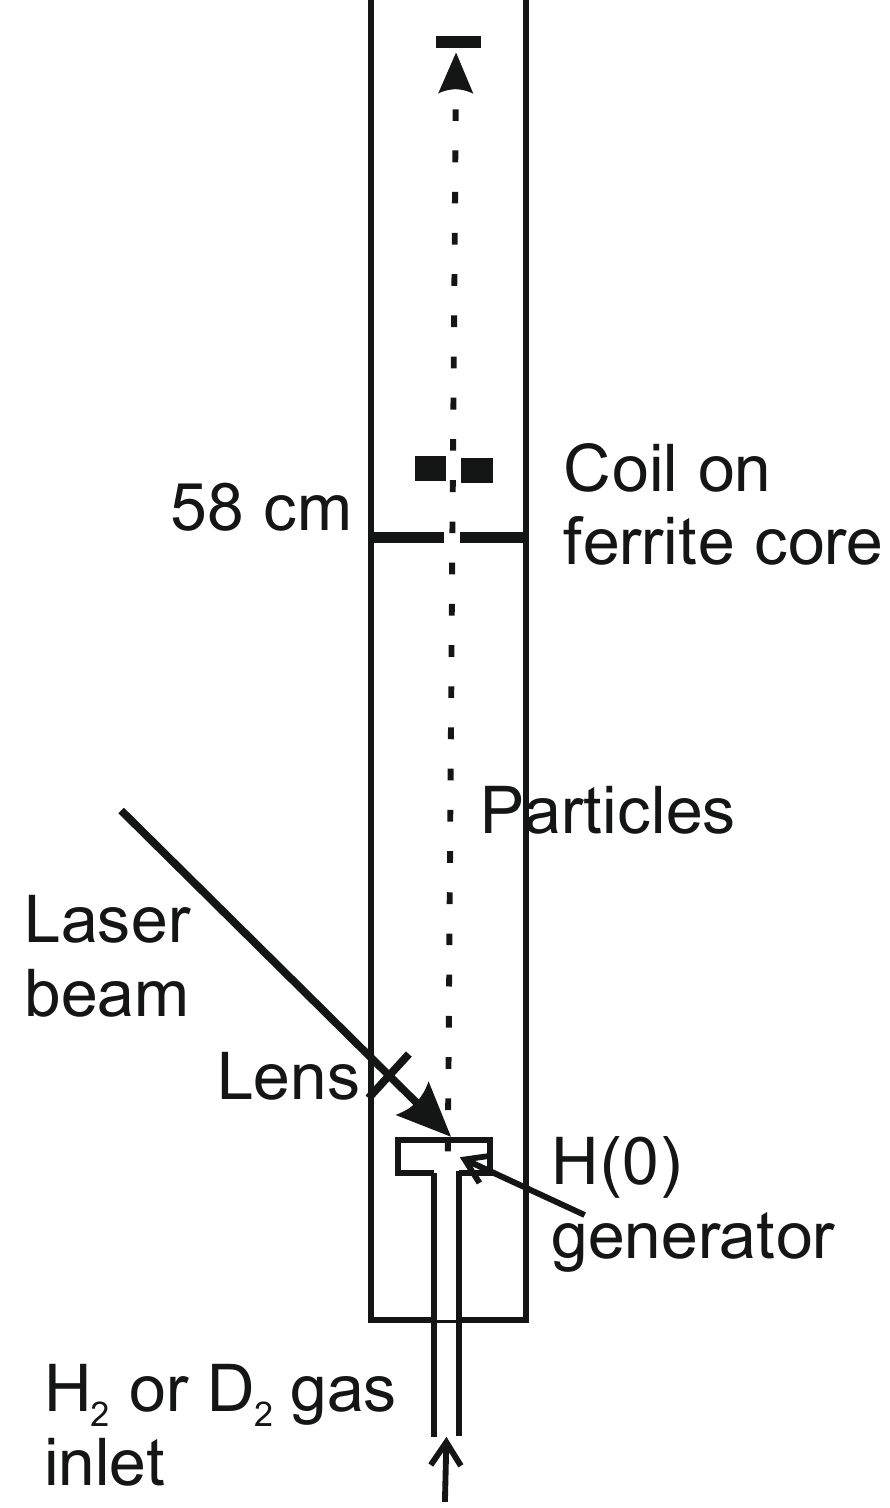
Figure 1. Schematic drawing of the apparatus. Current coil [30,32] with 19 turns of wire on a ferrite toroid, at 58 cm from the laser target. The connection to the oscilloscope is differential to cancel all signals from the annihilation plasma [35,36].